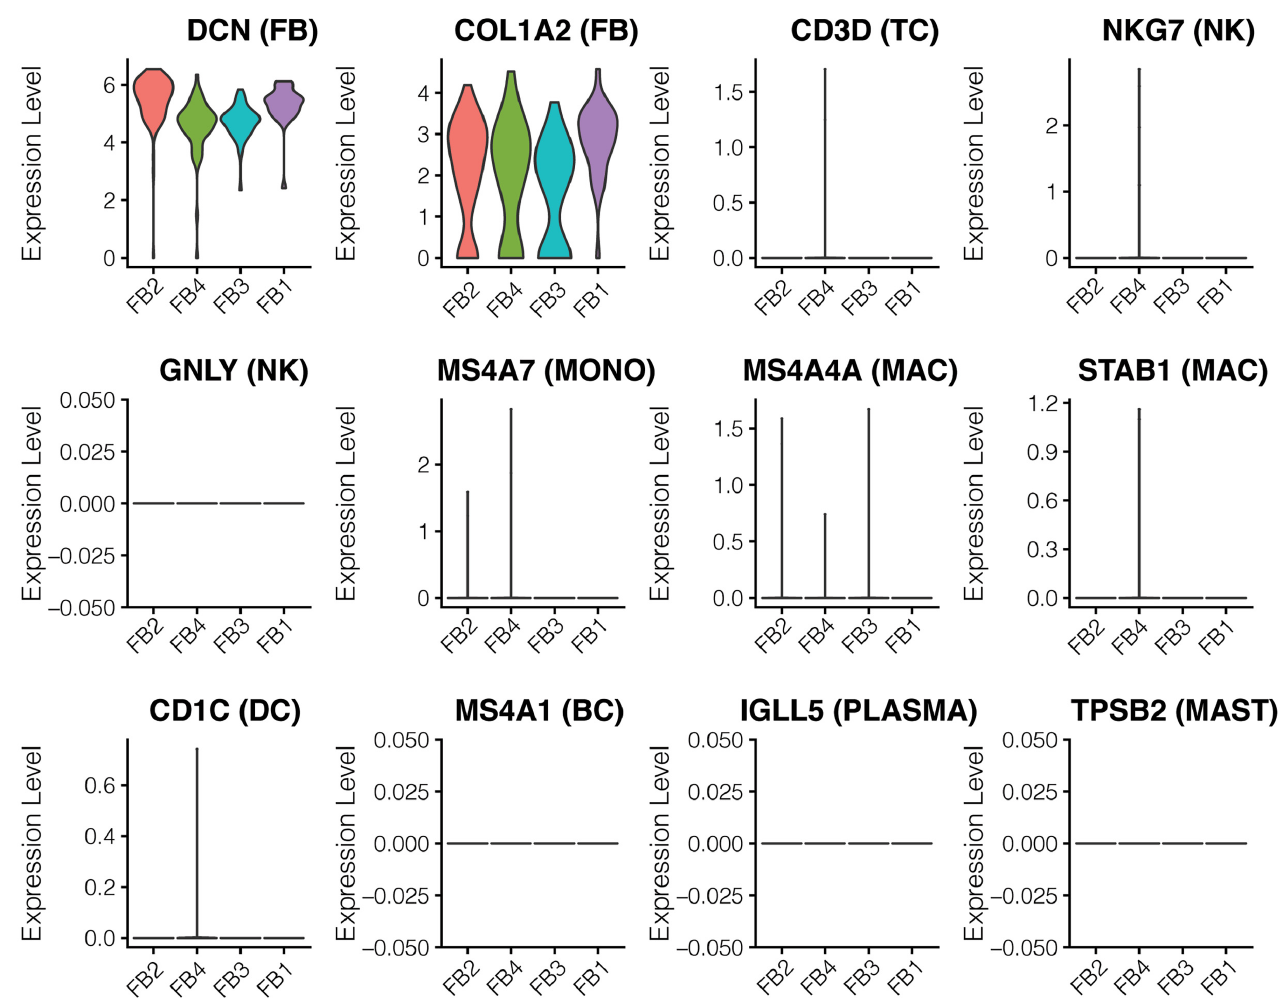
Fig 5. Expression of cell lineage markers in the fibroblast subpopulations. Figure depicts the violin plots showing expression of cell lineage markers in the fibroblast subpopulations. No lymphoid or myeloid cell lineage markers were expressed in the fibroblasts.